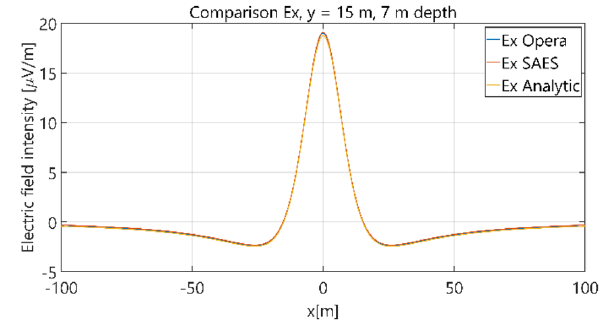
Figure 21. Distribution of E x component ( y = 15 m, z = − 7 m, case II).